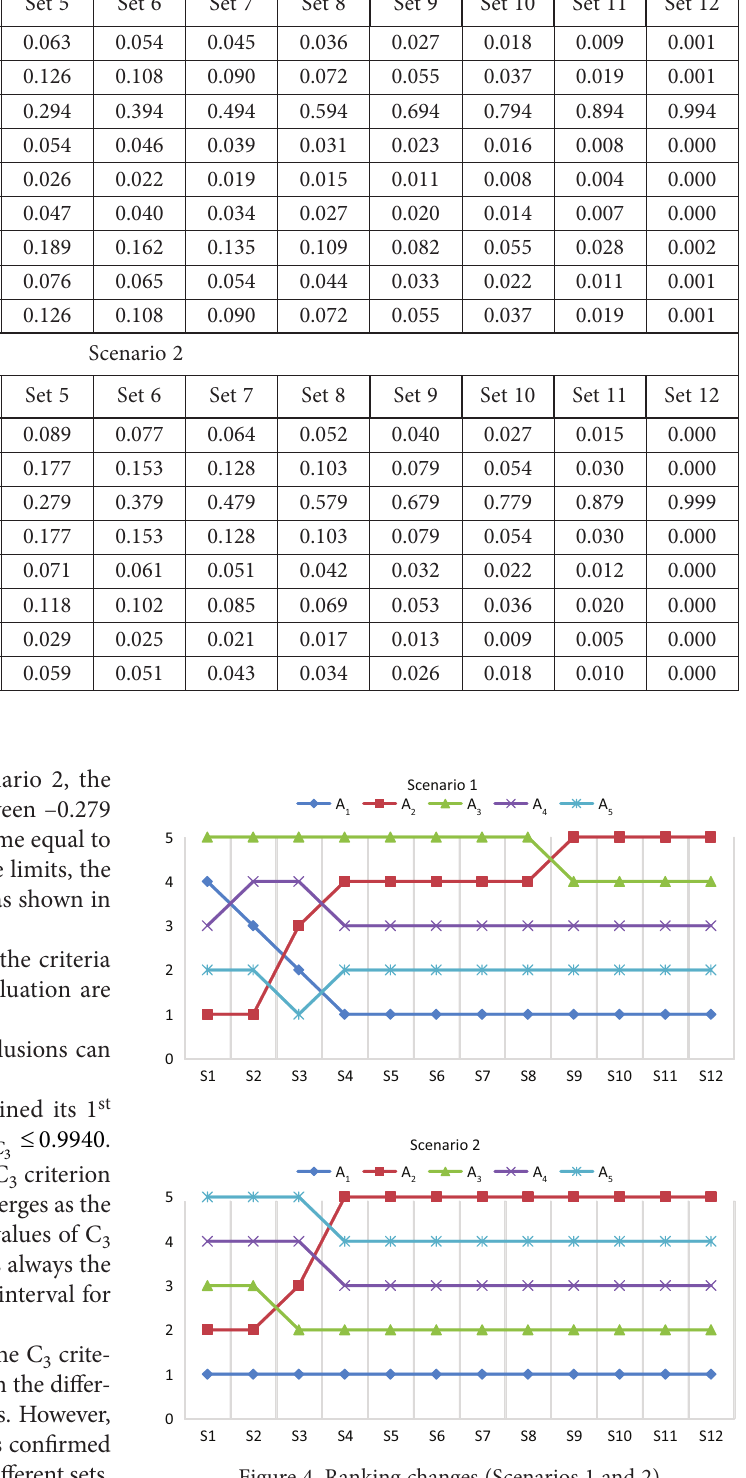
Figure 4. Ranking changes (Scenarios 1 and